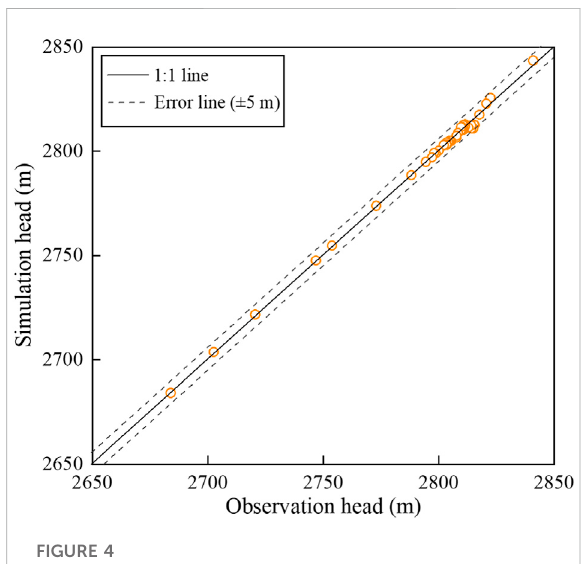
FIGURE 4 Comparison of observation head and simulation